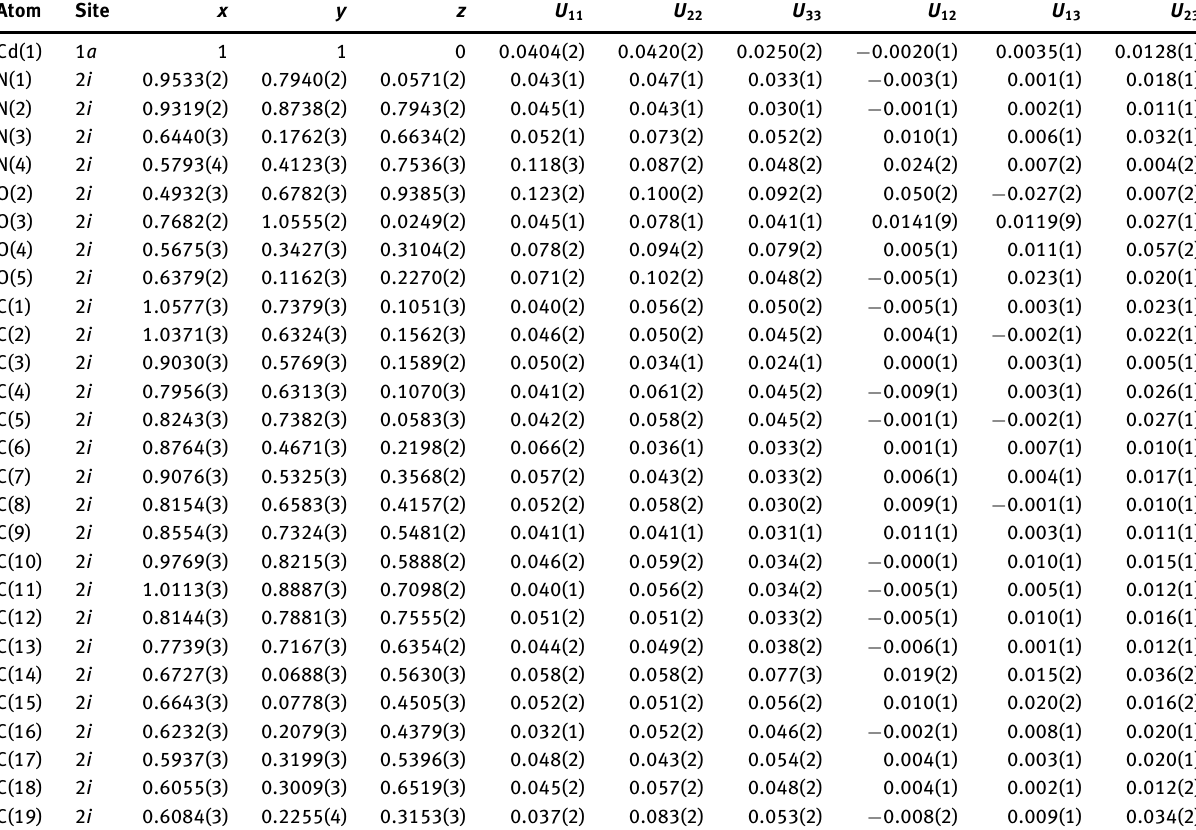
Table 3: Atomic displacement parameters (Å 2